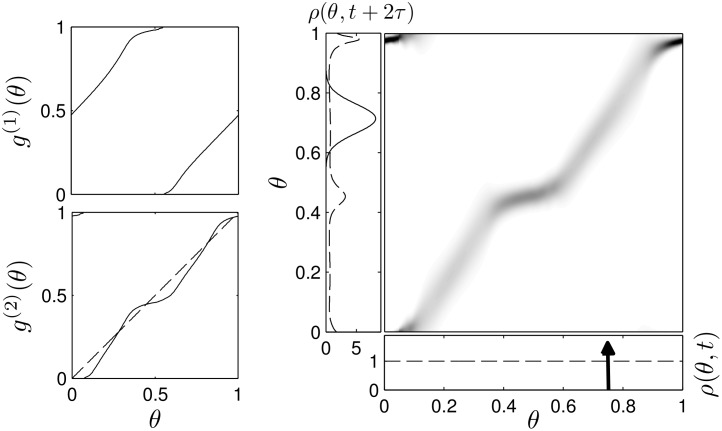
Deterministic and stochastic maps.The left panels show an example map g
(1) and g
(2), which is obtained from g
(1) for a given value of τ. The right panel shows stochastic matrix corresponding to g
(2), with darker regions representing larger numbers. After 2τ has elapsed, the delta function distribution (arrow) is mapped to a Gaussian distribution (solid line) while the uniform distribution is mapped to a bimodal distribution (dashed line).